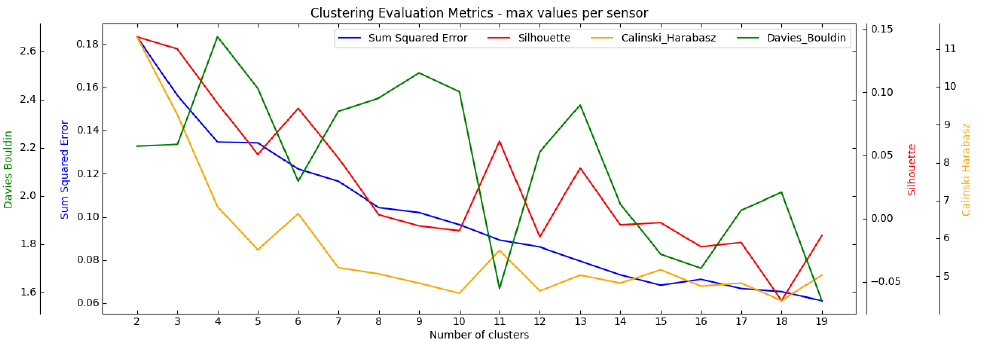
Figure 5. Clustering evaluation metrics for maximum values per sensor.